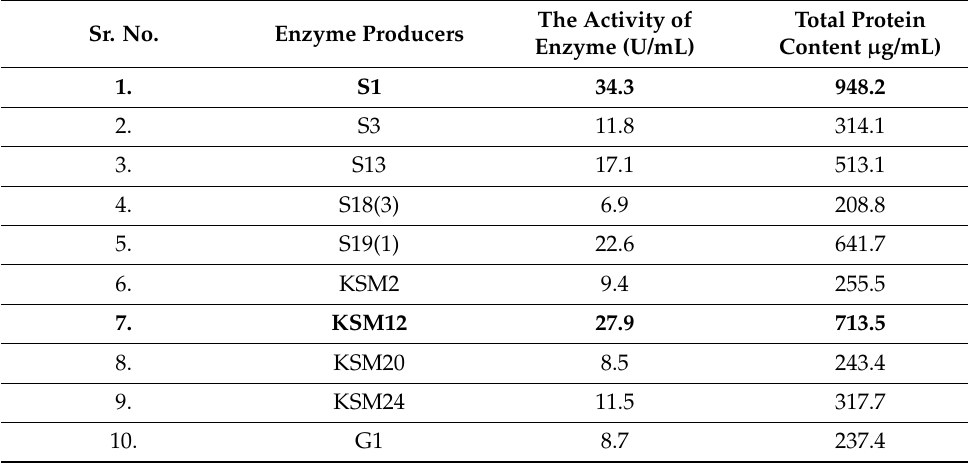
Table 1. Quantitative assay for protease production by the 14 selected isolates. The highest protease- producing strains (bold) were selected for further